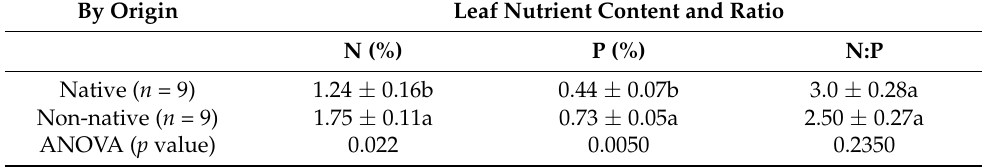
Table 2. Analysis of variance for leaf N, leaf P, and leaf N:P ratio of dominant native vs. non-native tree species in ultramafic areas affected by mining activities in Hinatuan Island, Taganaan, Surigao Del Norte,